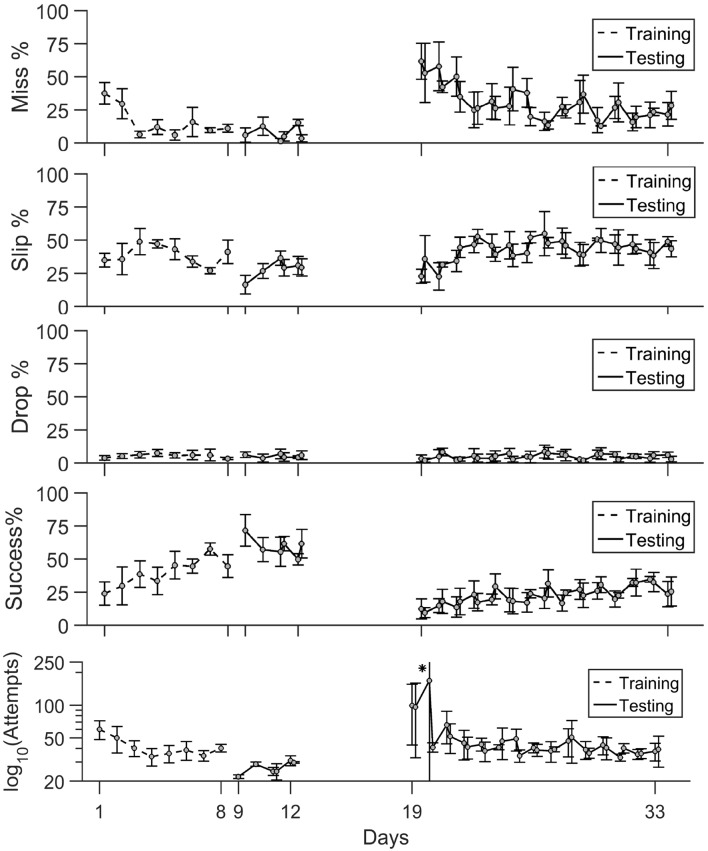
Timeline of task phase outcome. The percentage of misses, slips and drops together with success rate and number of attempts are shown during training (days 1–8), testing (days 9–11) and rehabilitation (days 19–33). Mean values ± standard deviation are shown. (*) In panel (v), the number of attempts is represented on a log scale. The mean value ± standard deviation on day 20 were [8.5 329.5].